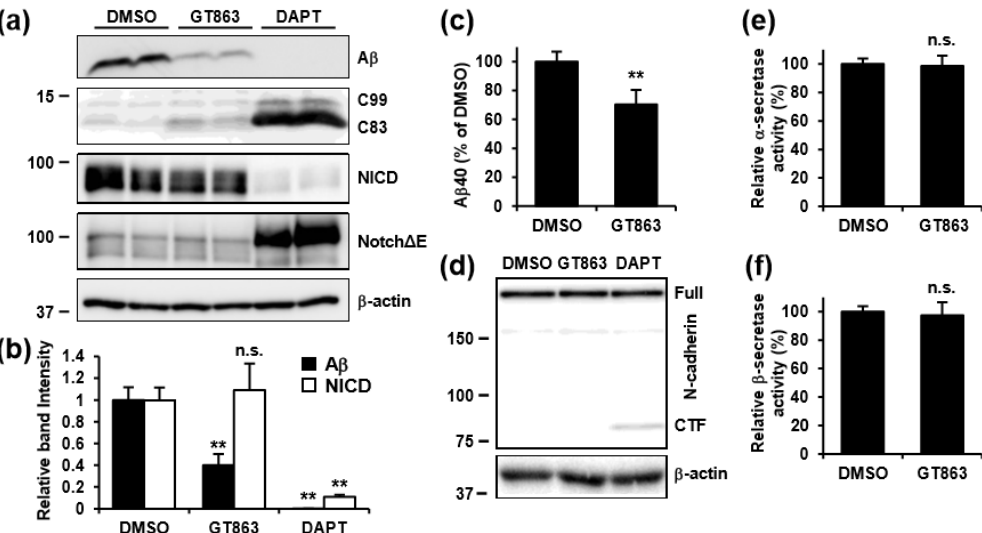
Figure 4. E ff ect of GT863 on activity of secretases. ( a ) CHO-APP / Notch ∆ E cells were treated with 3 µ M GT863 or 1 µ M DAPT for 48 h. Whole cell lysates were immunoblotted with appropriate antibodies as indicated. ( b ) Band intensities were quantified by densitometric scanning, relative intensity being shown. Mean ± SD n = 3, ** p < 0.01, n.s. = not significant. ( c ) SH-SY5Y cells were treated with 3 µ M GT863 for 24 h. Secreted A β 40 in conditioned media was measured by ELISA. n = 3. ** p < 0.01. ( d ) SH-SY5Y cells were treated with 3 µ M GT863 or 1 µ M DAPT for 24 h. Whole cell lysates were immunoblotted with appropriate antibodies specific for N-cadherin or β -actin. ( e,f ) α -secretase ( e ) or β -secretase ( f ) activity in SH-SY5Y cells treated with 3 µ M GT863 for 24 h was measured and normalized to control cells. n = 3. ** p < 0.01.